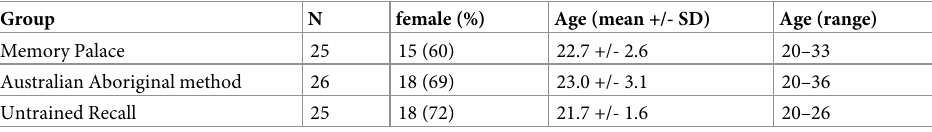
Table 1. Demographic information of recall test